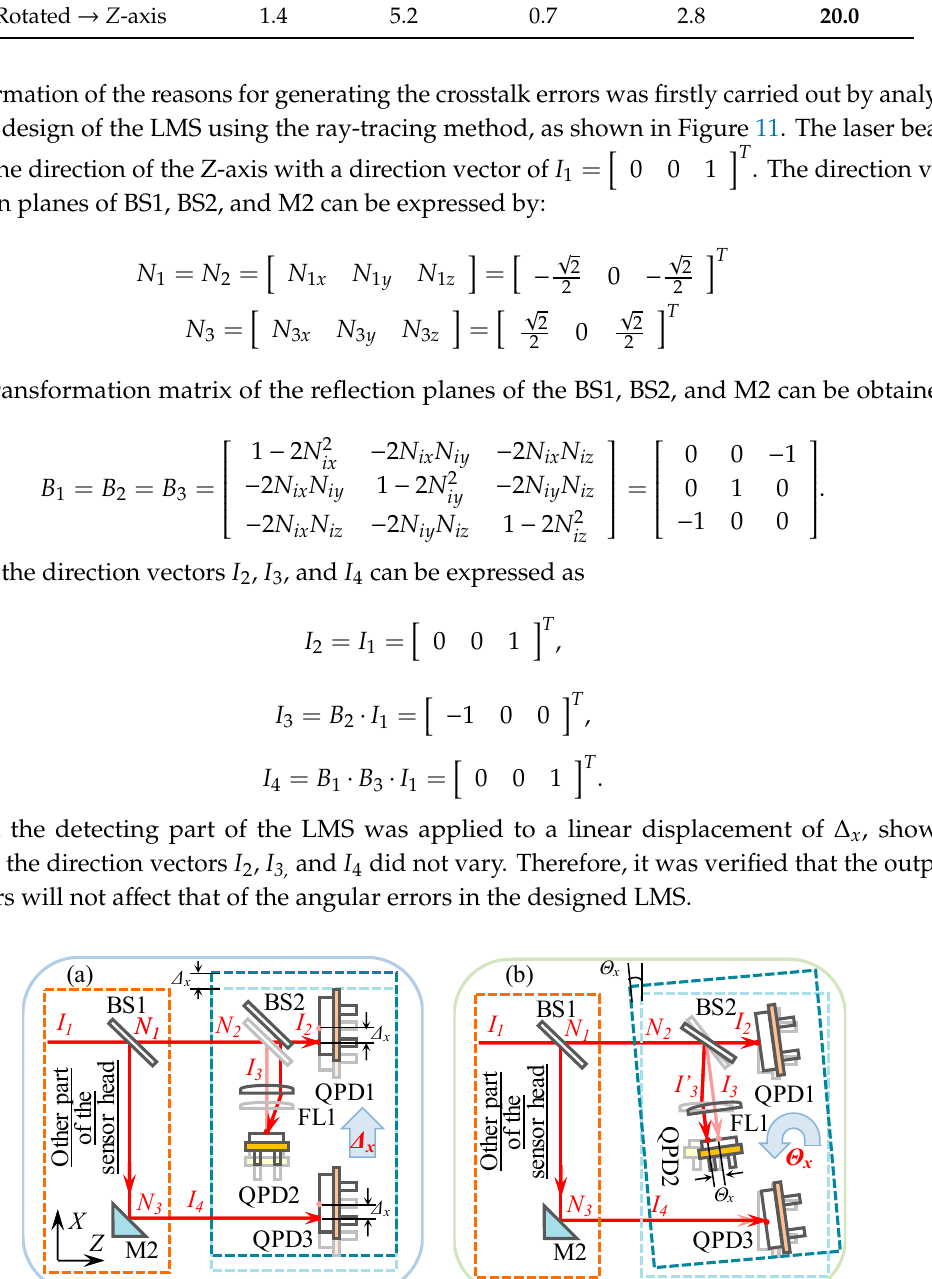
10 of 14 Table 1. Crosstalk errors of the LMS without compensation.